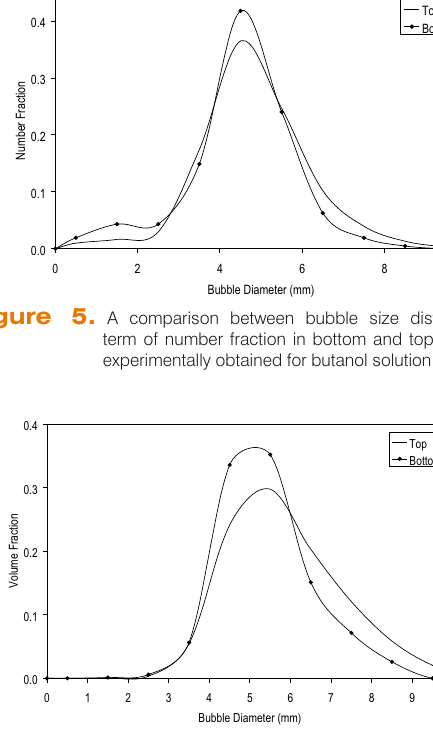
Figure 6. A comparison between bubble size distribution in term of volume fraction in bottom and top of column experimentally obtained for butanol solution.